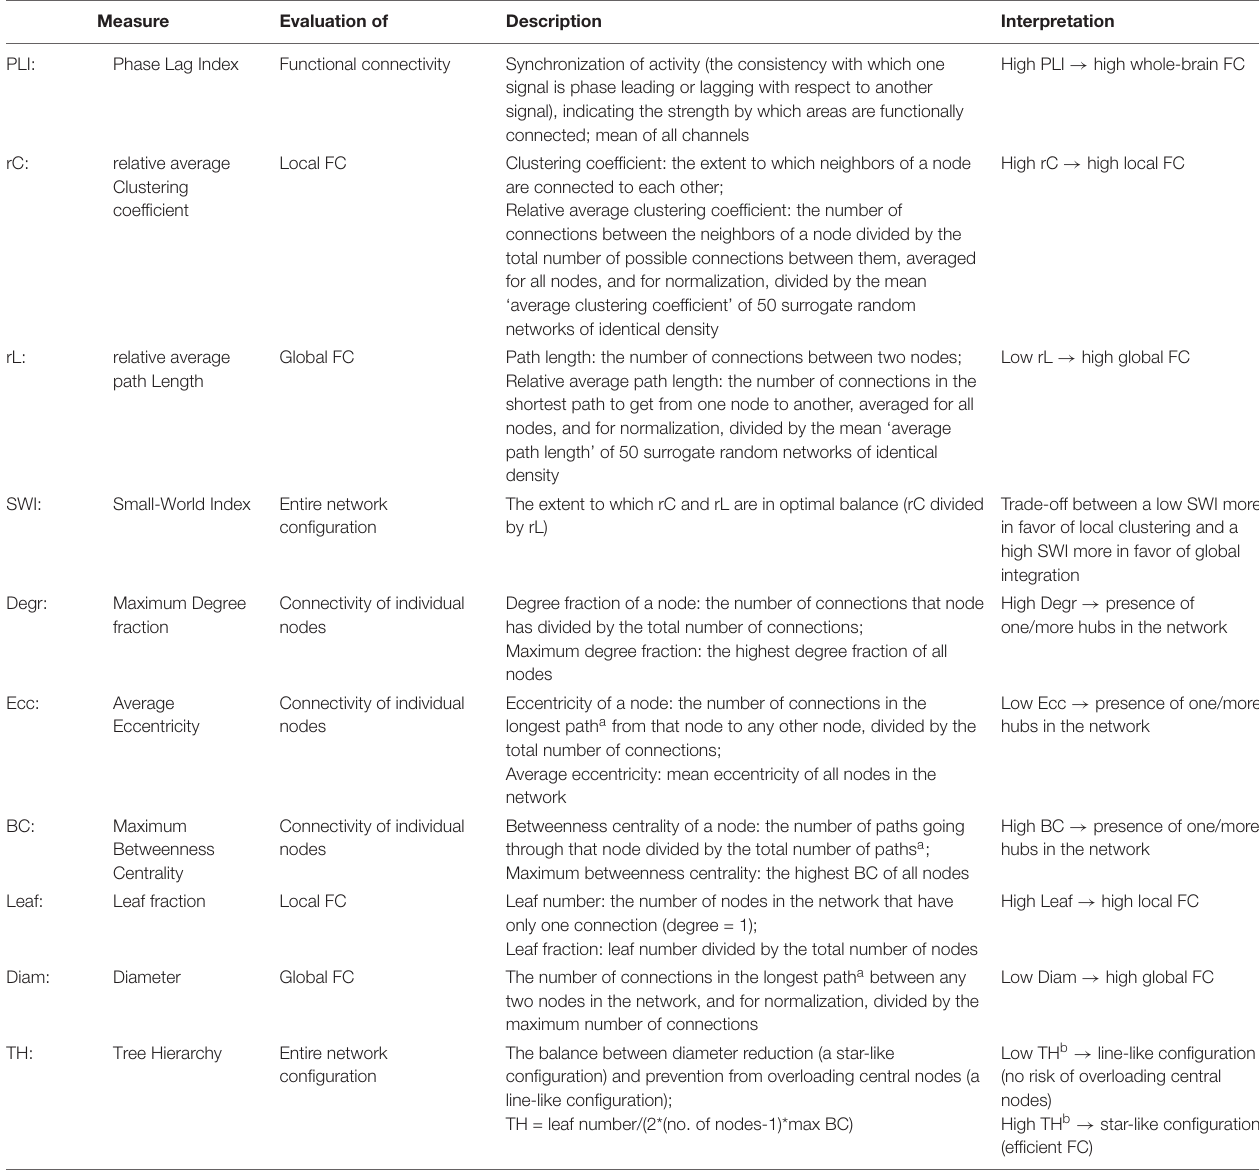
TABLE 2 | Network measures used for the quantification of the functional connectivity (FC) brain networks. Measure Evaluation of Description